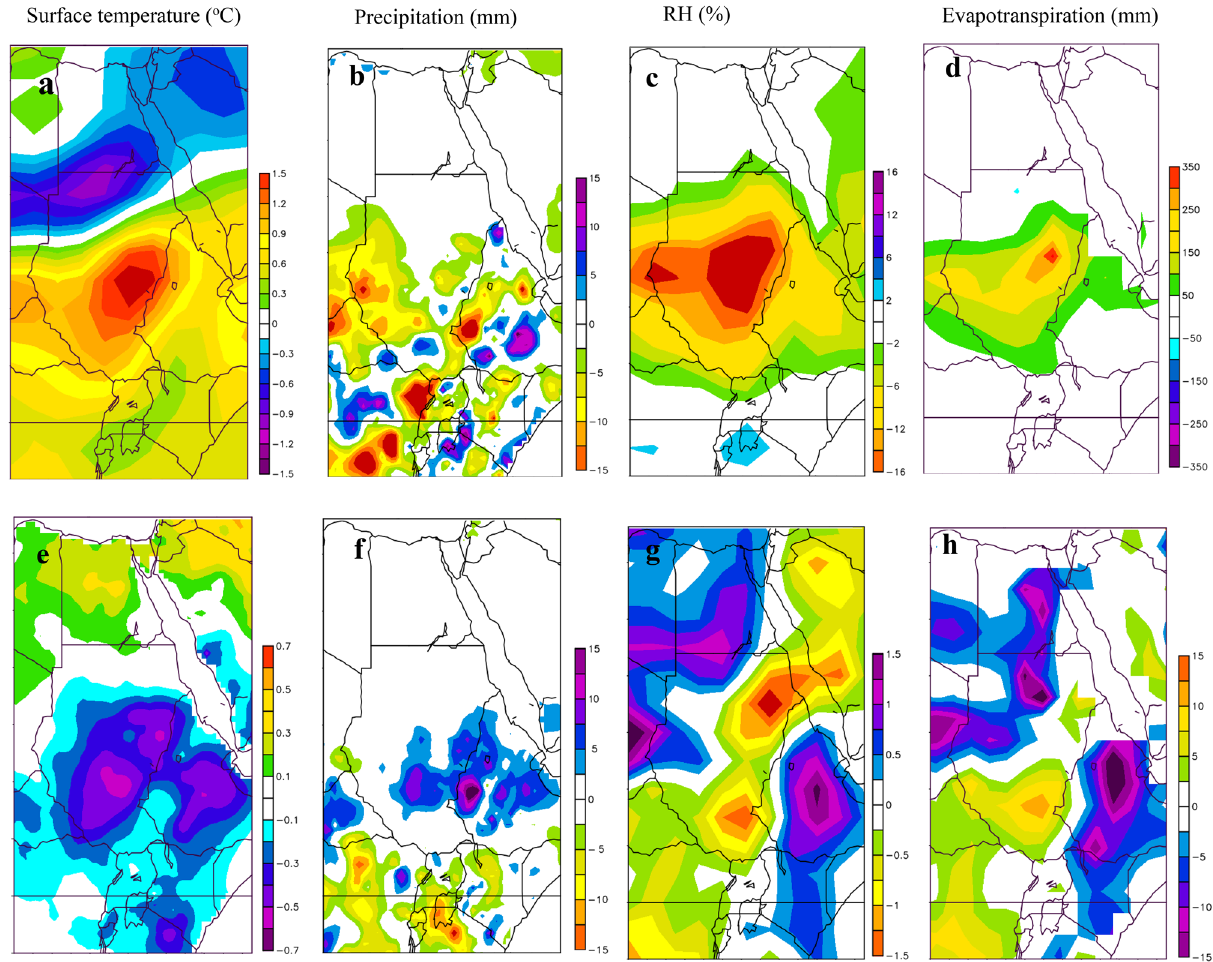
Figure 7. The effect of positive and negative IOD events in the NRB shown by composite of NRB’ surface temperature associated with positive IOD ( a ) and negative IOD ( e ) episodes, composite of precipitation associated with positive IOD ( b ) and negative IOD ( f ) episodes, composite of relative humidity associated with positive IOD ( c ) and negative IOD ( g ) episodes, and composite of evapotranspiration associated with positive IOD ( d ) and negative IOD ( h ) episodes. The maps were generated with NCAR Command Language (NCL) Version 6.2.1 (http:// www. ncl. ucar. Burundi. During pure El Niño events, the upper part of the NRB experiences a large decrease in RH (− 3 to − 27%) (Fig. 6c), resulting in higher-than-normal evapotranspiration (30–210 mm) (Fig. 6d). Overall, we note that evapotranspiration is the highest above countries that showed a large increase (decrease) in surface tem- perature (RH). Despite the cooling influence of La Niña events, surface temperature is warmer than normal in the majority of the NRB (0.2 to 1 °C) except for Ethiopia which shows a drop of − 0.2 to − 0.4 °C (Fig. 6e). In contrast, above normal precipitation occurs in most parts of the NRB during pure La Niña events (5–15 mm). On the other hand, Fig. 6g–h show slight decrease (increase) in RH (evapotranspiration) in comparison to the pattern during pure El Niño events. Figure 7 shows a far stronger influence from the positive phase of IOD than the negative phase IOD in the NRB’ climate. For instance, surface temperature anomaly composites of positive IOD events shows higher than normal surface temperature over the upper part of the NRB (0.3–1.5 °C) (Fig. 7a), this is a mirror image of the pure El Niño warming signal, but the influence is slightly lower. The composites of precipitation in Fig. 7b show below normal precipitation over the upper part of the NRB (− 3 to − 15 mm), which indicates that posi- tive IOD events intensify the influence of positive ENSO events in the NRB precipitations. Like positive ENSO events, positive IOD events caused a decrease in RH and increase in evapotranspiration over the upper part of the NRB (Fig. 7c,d). On the other hand, negative IOD events impose a widespread colder-than-average surface temperature over the upper part of the NRB (− 0.1 to − 0.7 oC), and wormer than average surface temperature over Egypt (0.1–0.7 °C) (Fig. 7e). Negative IOD events also associated with higher-than-average precipitation (5–15 mm) over Ethiopia and Sudan, and below average precipitation (− 5 to − 15 mm) over Kenya, Uganda, Tanzania, Rwanda, and Burundi (Fig. 7f). Figure 7g–h also shows increase (decrease) in RH (evapotranspira- tion) over Ethiopia, Kenya, and Tanzania. In contrast, to lower (higher) than average RH (evapotranspiration)